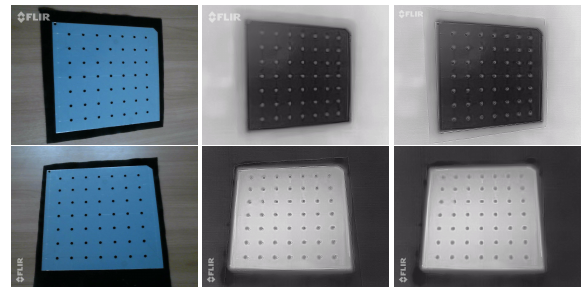
Figure 3. Sample images used for joint